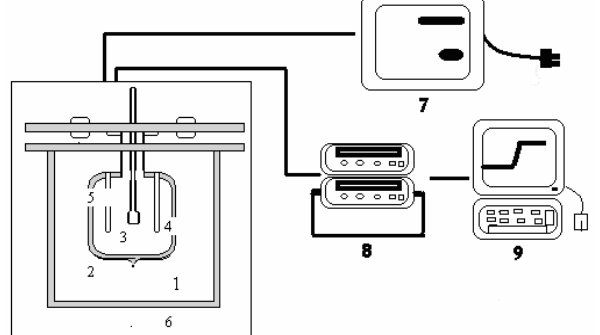
Figure 2. Dissolution isoperibol microcalorimeter general schematic diagram, ( 1 Internal jacket, 2 Dewar vessel, 3 Glass ampoule, 4 Thermistors, 5 Calibration resistance, 6 External jacket, 7 Breaking control, 8 Multimeters, 9 Interphase capture data